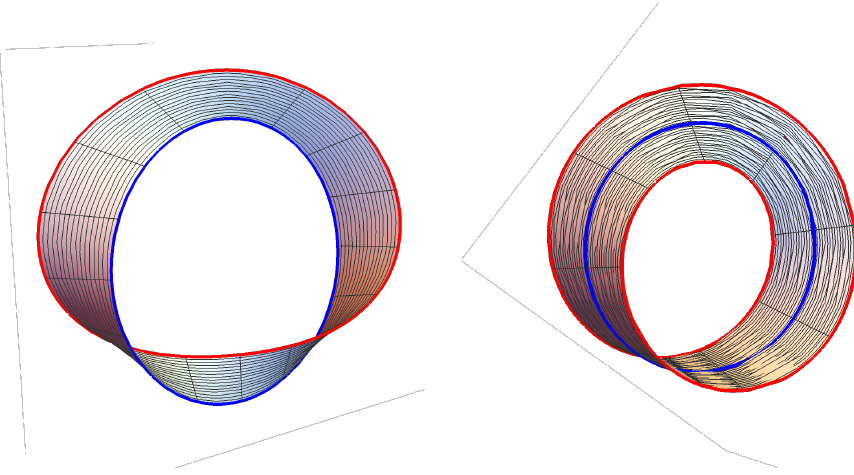
Figure 2 . The blue cycle represents the twisted time cycle Γ located at θ = 0 (resp. θ = π ) Γ θ =0 (resp. Γ ). The red cycle represents the electric cycles Γ θ = π 2 the regions Σ (resp. Σ ). The figure to the left corresponds to the case ( m = 1 , n = 2) . In this eN eS case the ribbon is orientable and its boundary is Γ to the case ( m = 1 , n = 1) . In this case the ribbon is unorientable and its boundary is Γ